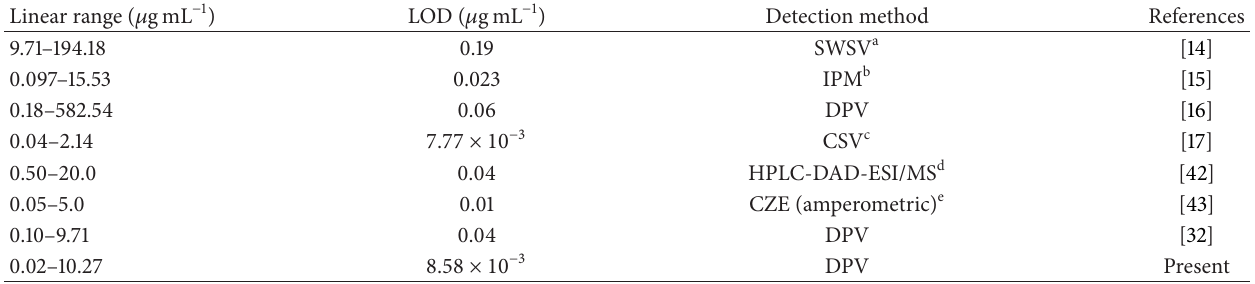
Table 3: Comparison of different analytical methods for the detection of